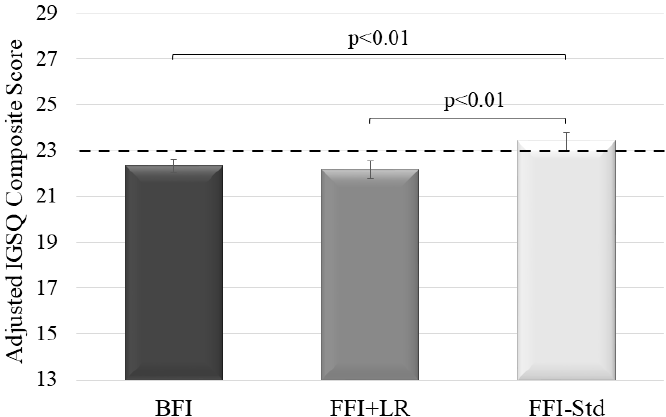
Figure 1. Adjusted mean IGSQ composite scores ± SE by feeding groups. Group comparison done by analysis of covariance adjusted for feeding group, study site, infant age, sex, delivery type, history of GI disease in parents and mother’s education. IGSQ composite score can range from 13–65, with higher values indicating greater discomfort. Dotted line marks threshold of 23 indicating certain GI discomfort (>23 to 30; >30 to 65 indicates GI distress) and essentially no GI issues ( ≤ 23). BFI—Breastfed infants; FFI + LR—Infants fed formula with L. reuteri ; FFI-Std—Infants fed standard formula without any probiotic or prebiotic; GI, gastrointestinal; IGSQ, Infant Gastrointestinal Symptom Questionnaire. n = 760 in BFI; n = 501 in FFI-Std; n = 470 in FFI +